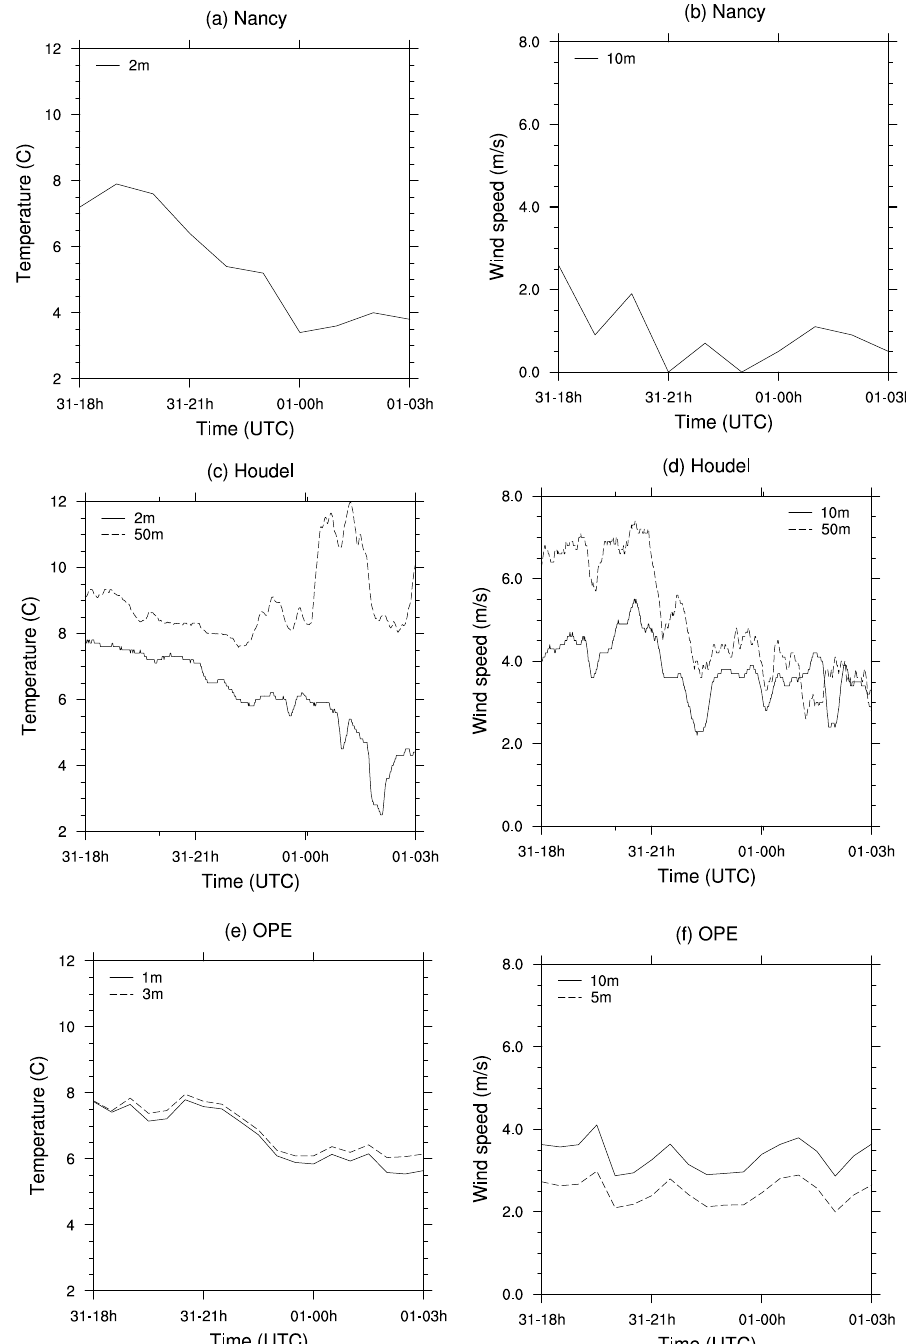
Figure 3. Temperature (left panel: a , c , e ) and wind speed (right panel: b , d , f ) observed for the three observing